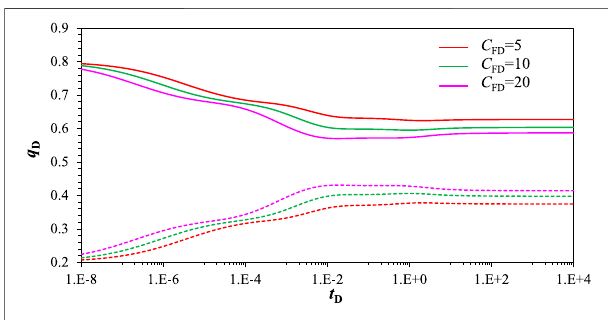
FIGURE 7 | Pressure transient responsecurve effected by dimensionless conductivity. ( C D = 1e-5, S = 0.01, x asymD = 0.3, L F = 150 m, θ F = 90 o , R e = 3000 m, r o = 2000 m, ω = 0.1, λ = 1, σ = 0.7, β m = 3).